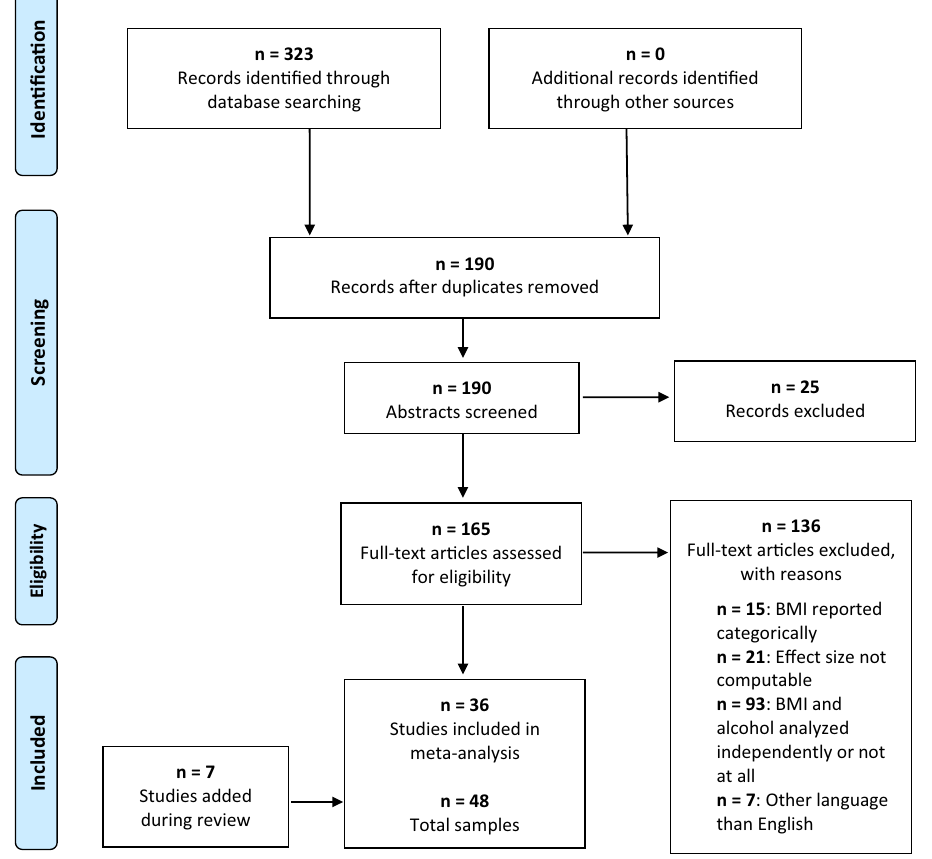
Figure 1. The PRISMA flow chart. This flow diagram visualizes the systematic literature search for eligible studies as well as reasons for exclusion of uneligible